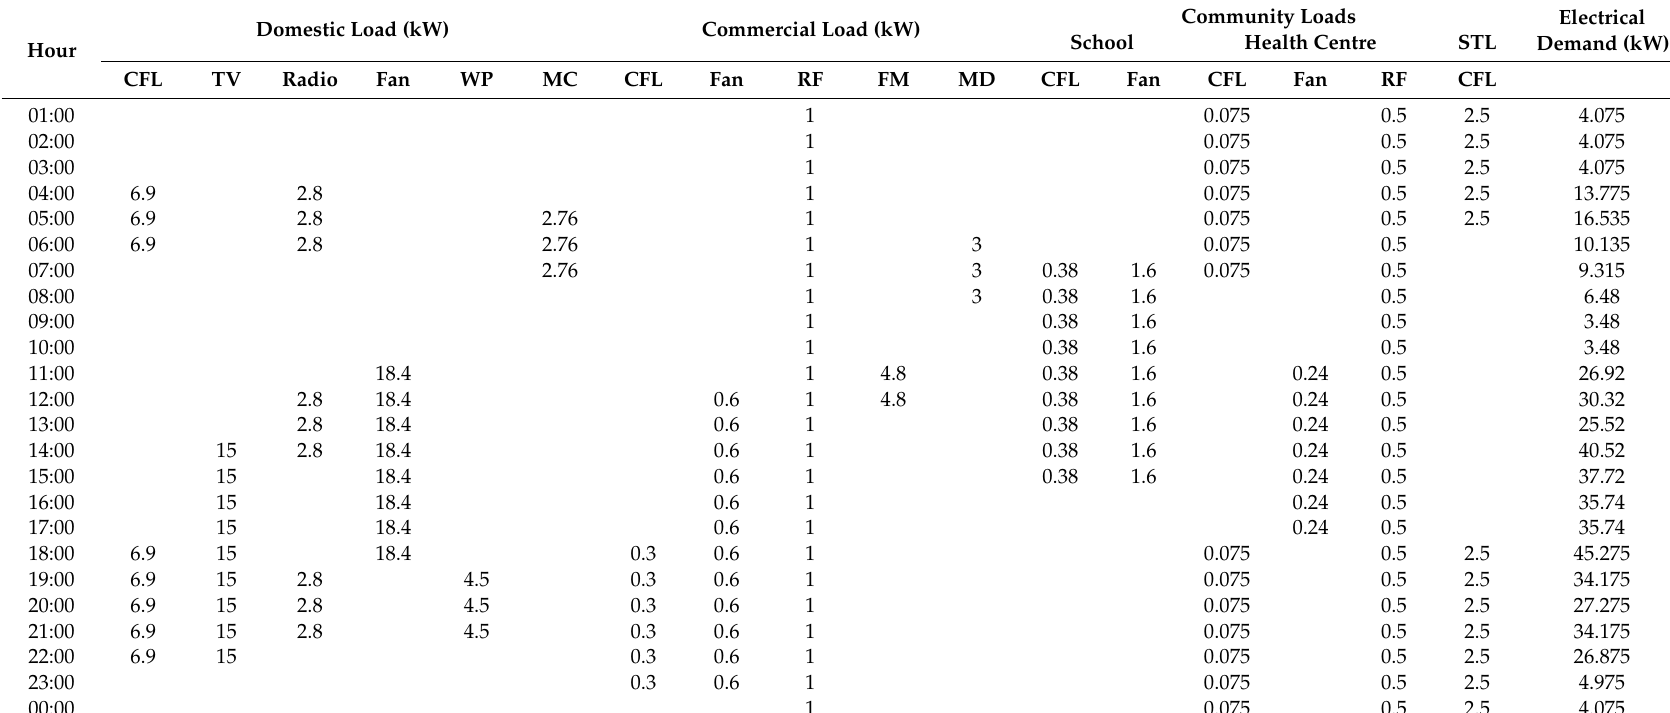
Table 3. Hourly electricity demand for the study